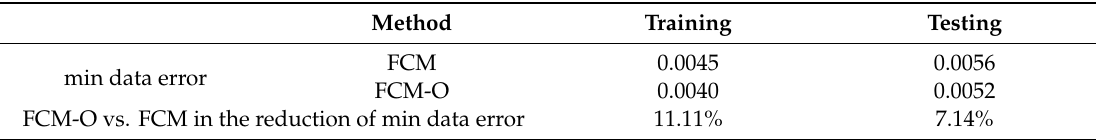
Table 3. The min data error of the fuzzy cognitive map (FCM) and fuzzy cognitive map with o ff set (FCM-O) for training and testing.